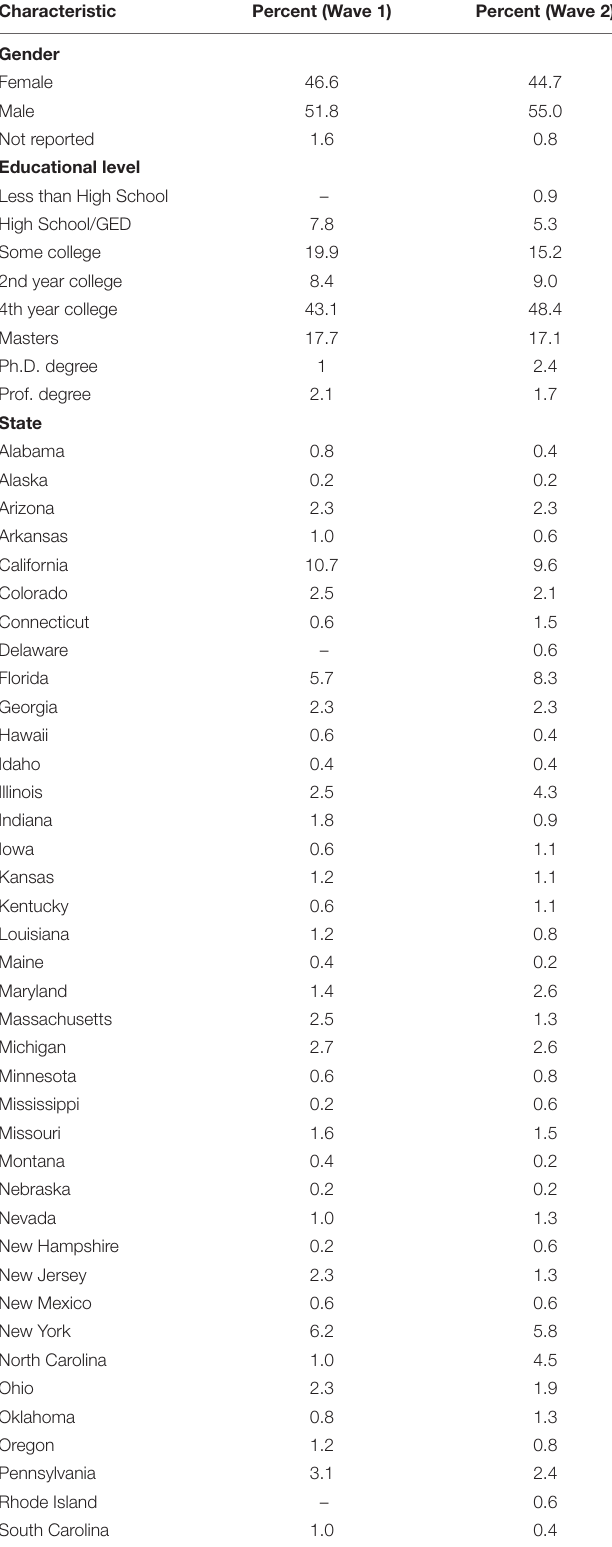
TABLE 1 | Characteristics of the participants (wave 1: N = 486; wave 2: N = 533). Characteristic Percent (Wave 1)